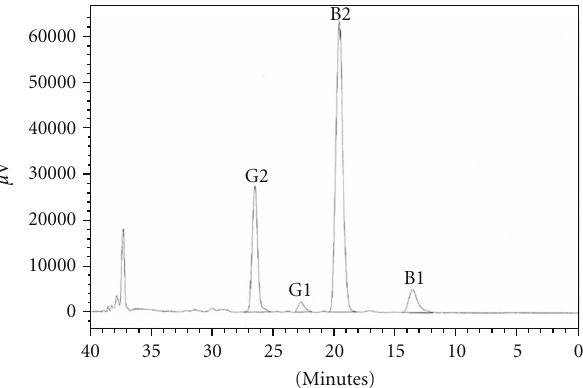
Figure 2: HPLC chromatogram of aflatoxins (B1, B2, G1, and G2) obtained from nuts sample contaminated by A. parasiticus